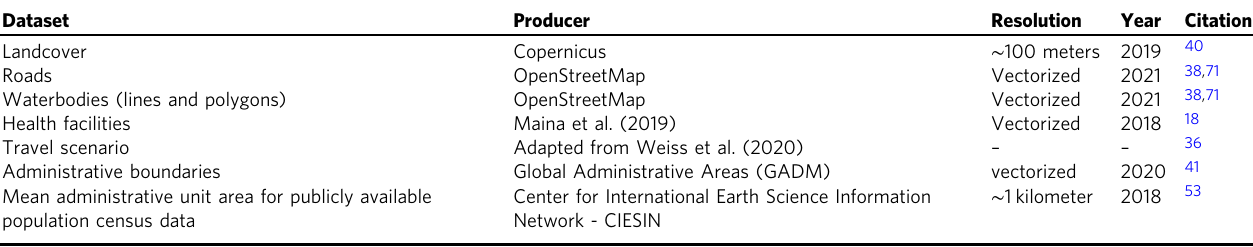
Table 1 Overview of spatial data sources used in the